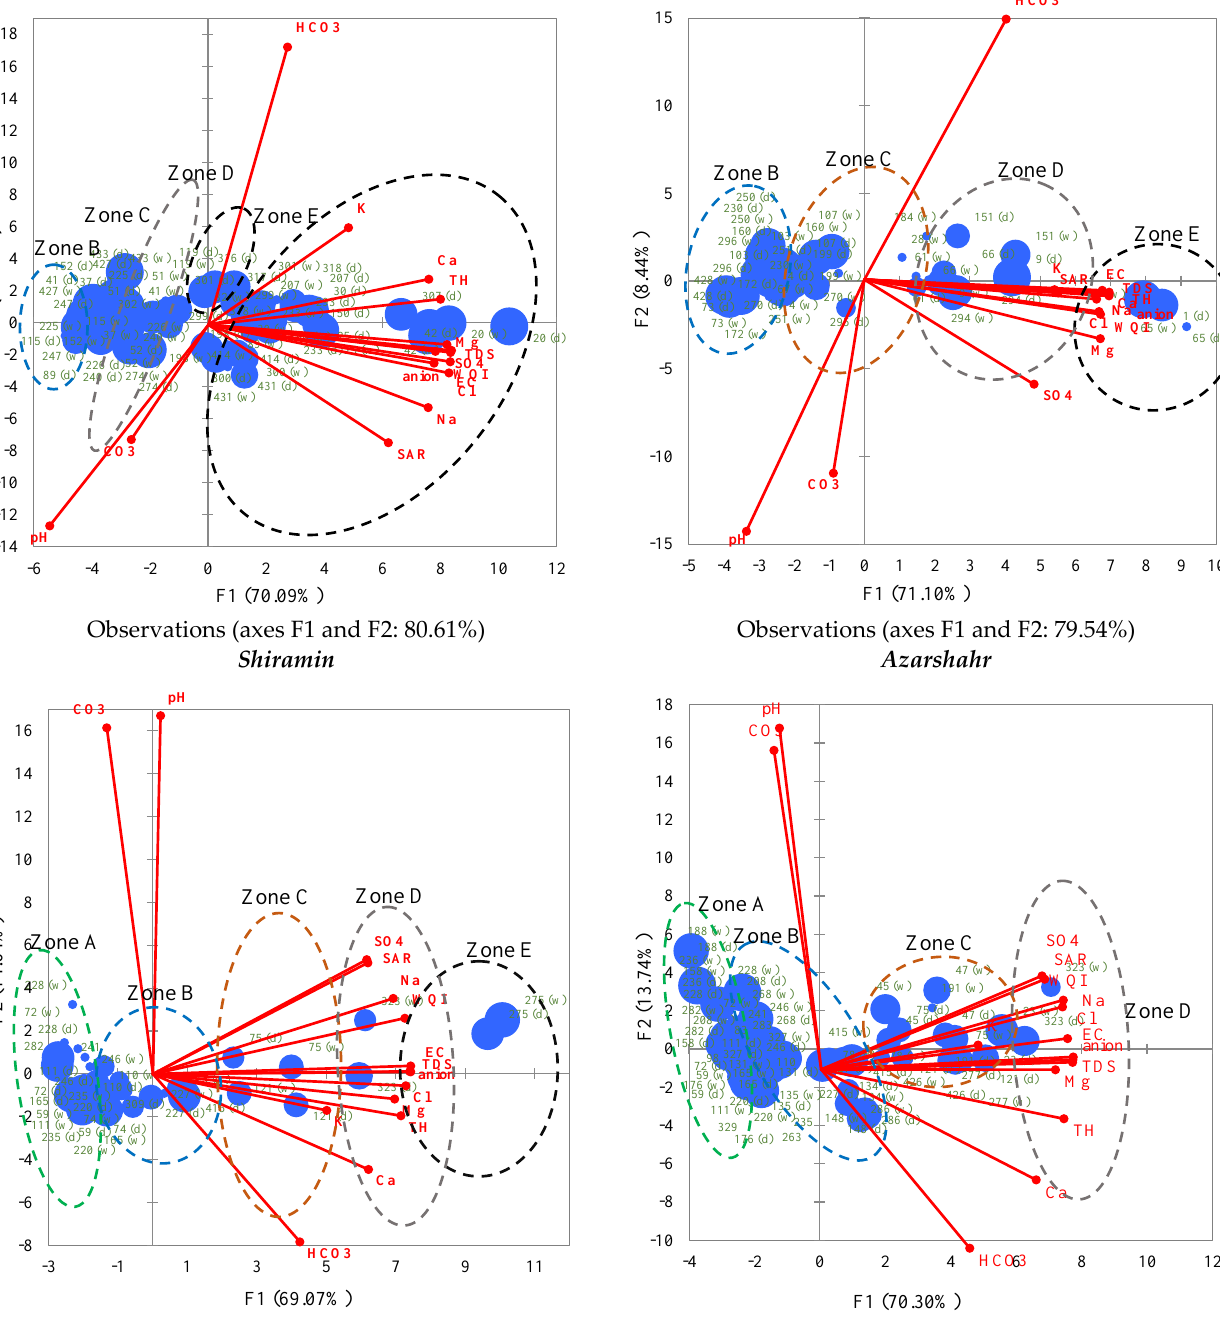
Observations (axes F1 and F2: 83.12%) Observations (axes F1 and F2: 84.03%)